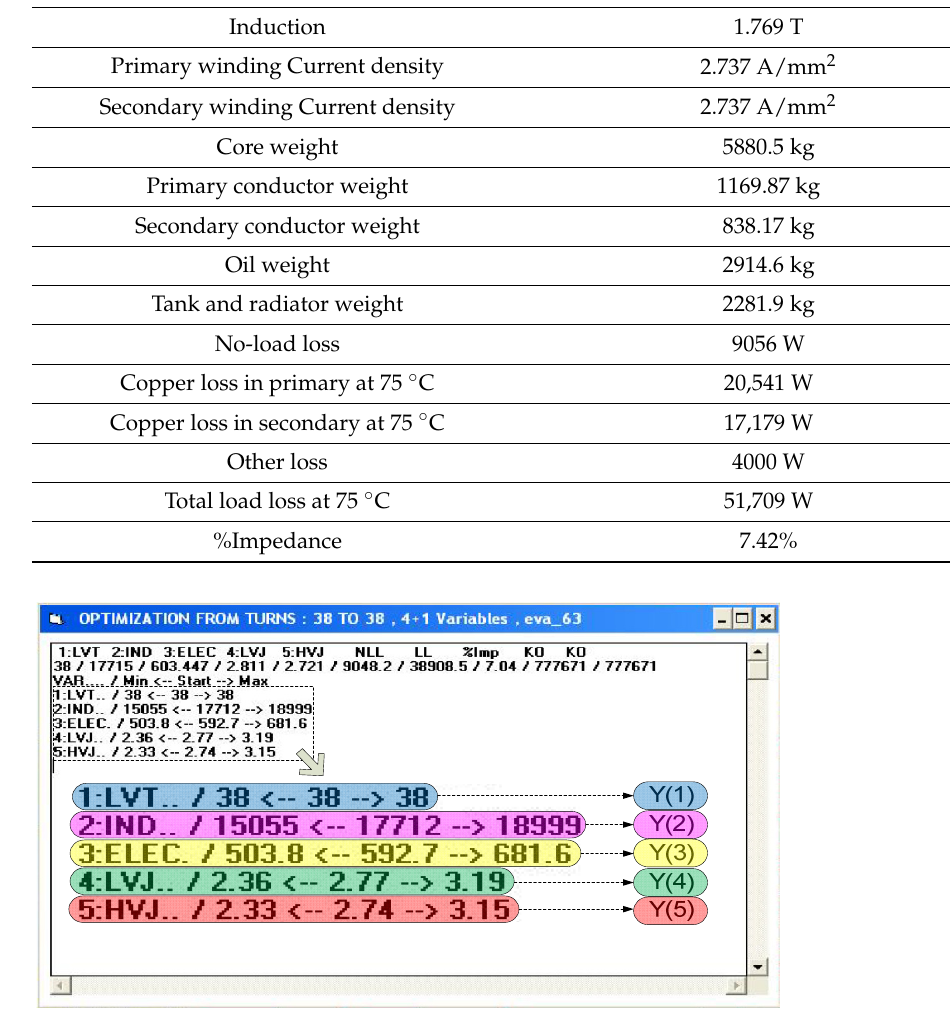
Table 2. Design output.